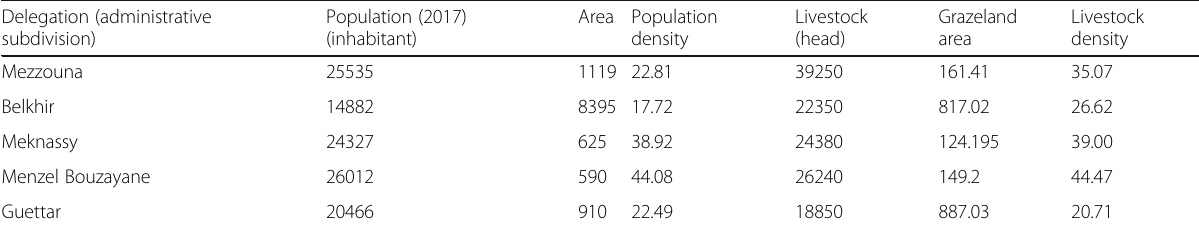
Table 7 Main management indicators in study area source: INS, ODCO, ODS (Copernicus open access hub n.d.; Office de développement du Centre ouest (ODCO) 2017; Office de développent du Sud (ODS) 2017)